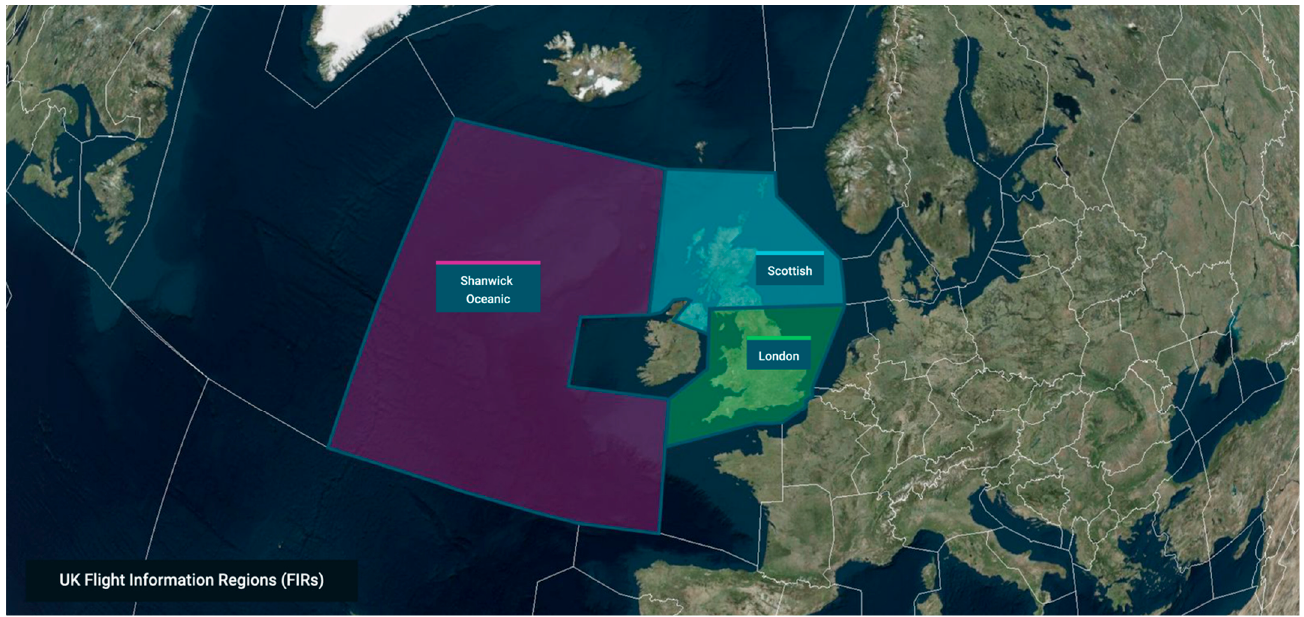
Figure 1. Map of Flight Information Regions managed by NATS [45].